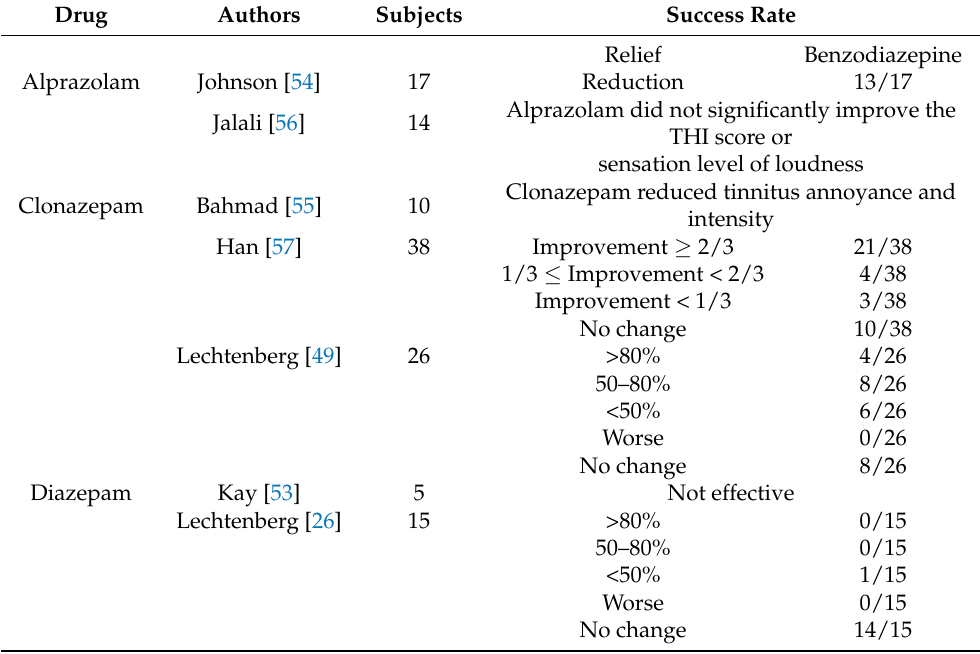
Table 7. Summary of studies that used benzodiazepine to treat